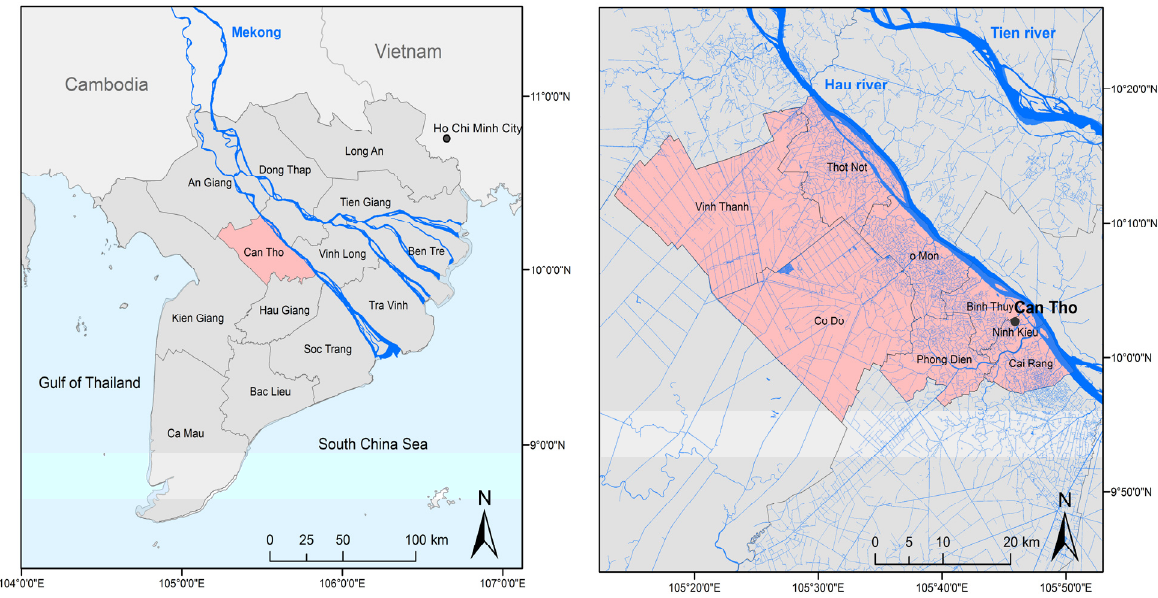
Figure 1. The Mekong Delta with its 13 Vietnamese provinces in the South of Vietnam ( left ). Can Tho province is located in the center of the delta. Can Tho City, the largest city within the delta, is located at the southern tip of Can Tho province. The individual districts of Can Tho are depicted in ( right